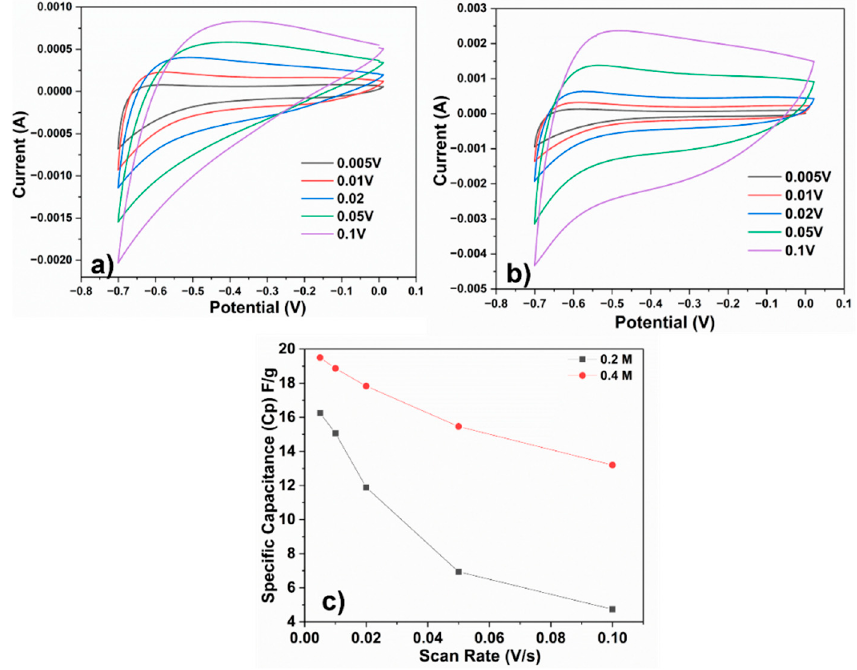
Figure 4. Cyclic voltammograms of ( a ) 0.2 M sample and ( b ) 0.4 M sample. ( c ) Plots of speci fi c capacitance versus potential scan rate of samples.